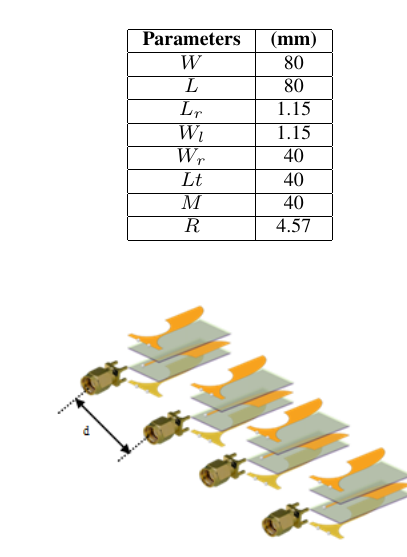
TABLE 1. Antenna Parameters(Antipodal Vivaldi antenna)